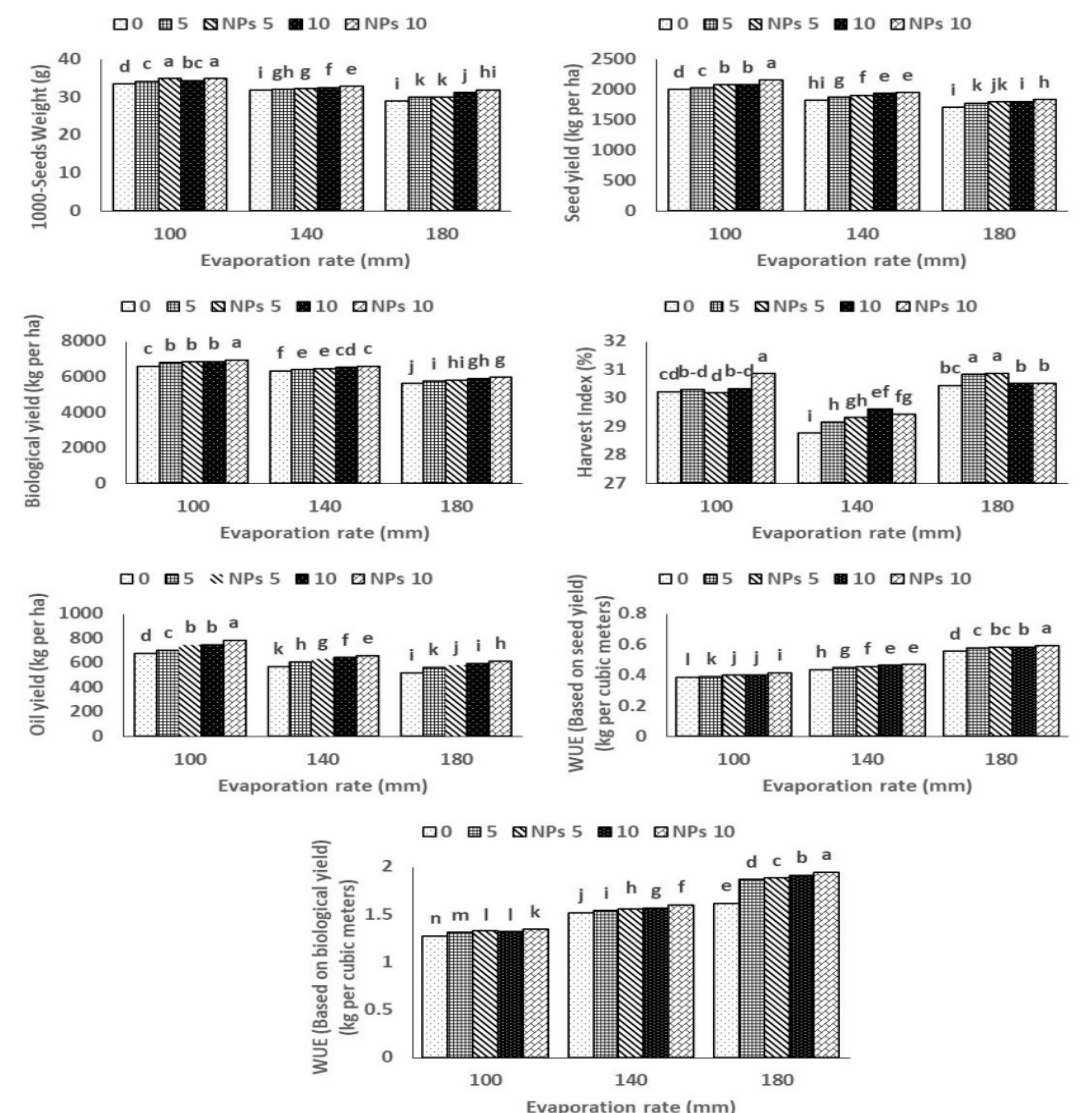
Figure 3. Interaction effects of irrigation regime and zinc spraying level on safflower traits. Different letters within each variable indicate significant differences at p < 0.05 based on Fisher’s protected LSD test.